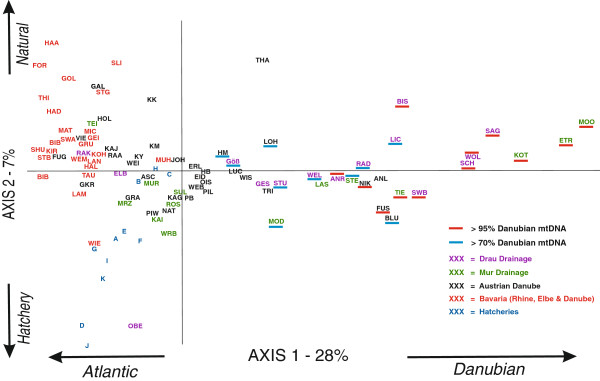
PCA of microsatellite frequency data. Principal components analysis based on microsatellite allele frequency data from 97 populations. Populations are colour-coded by major drainage, including hatcheries as a group. Populations carrying > 95% (blue bar) or between 70% and 95% (red bar) Danubian lineage mtDNA are additionally marked.